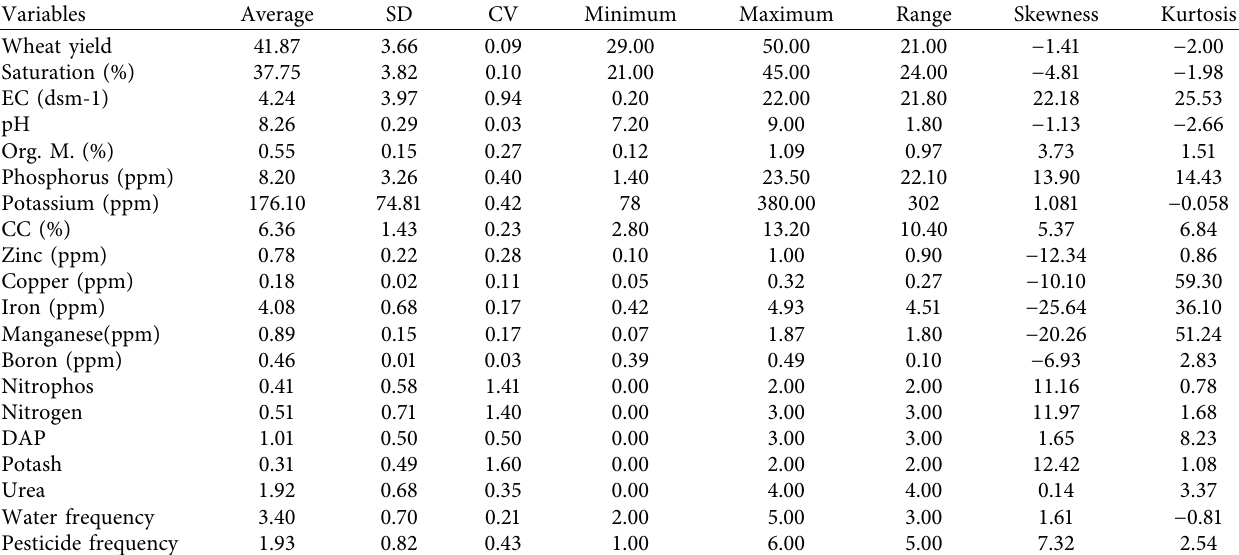
Table 3: Descriptive statistics of the consider